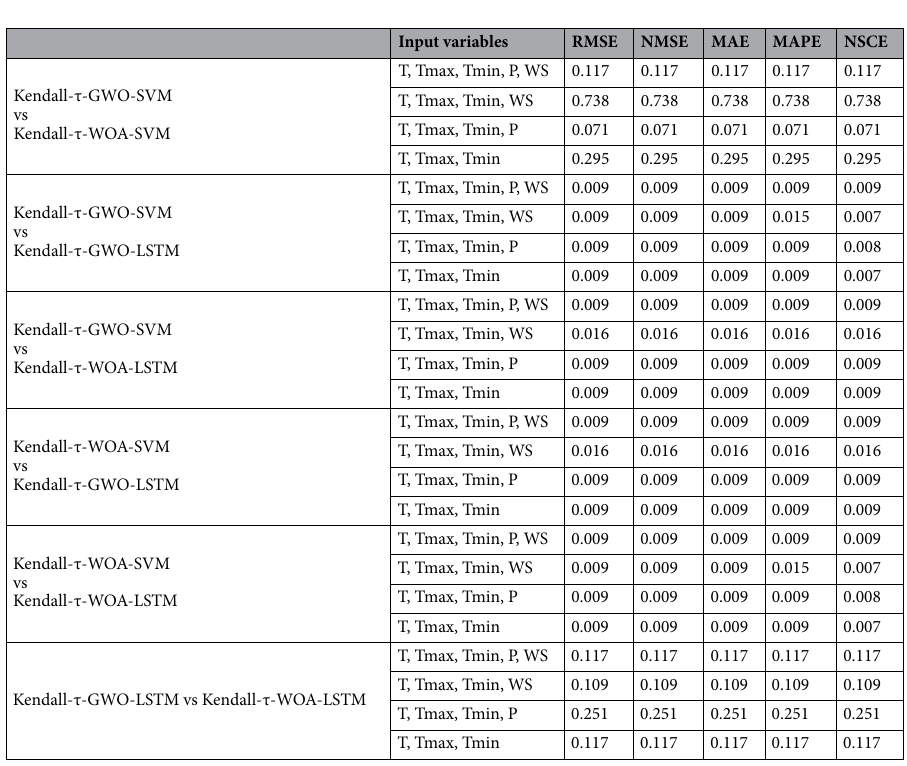
Table 9. The p -values of the K-W